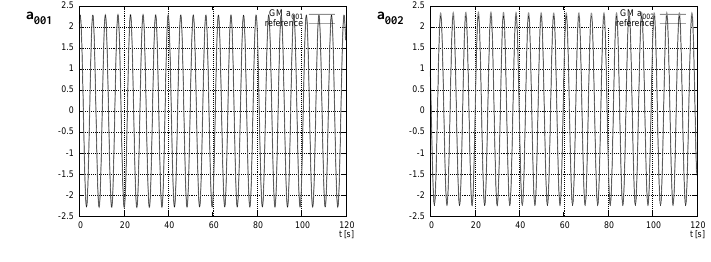
Figure 8. Three-equation Galerkin model with l + ij and q + ijk terms calibrated.